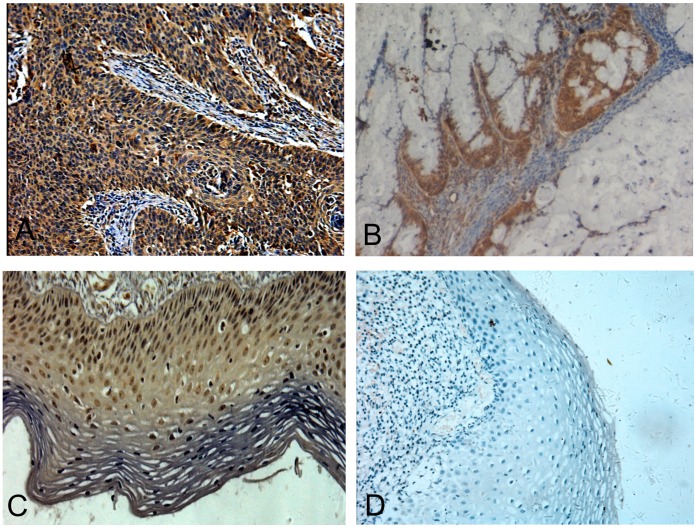
Representative immunohistochemical staining for Tim-3 in cervical tissues.(A) cervical squamous carcinoma, (B) cervical adenocarcinoma, (C) cervical intraepithelial neoplasia, and (D) chronic cervicitis tissue. Original magnification ×200.